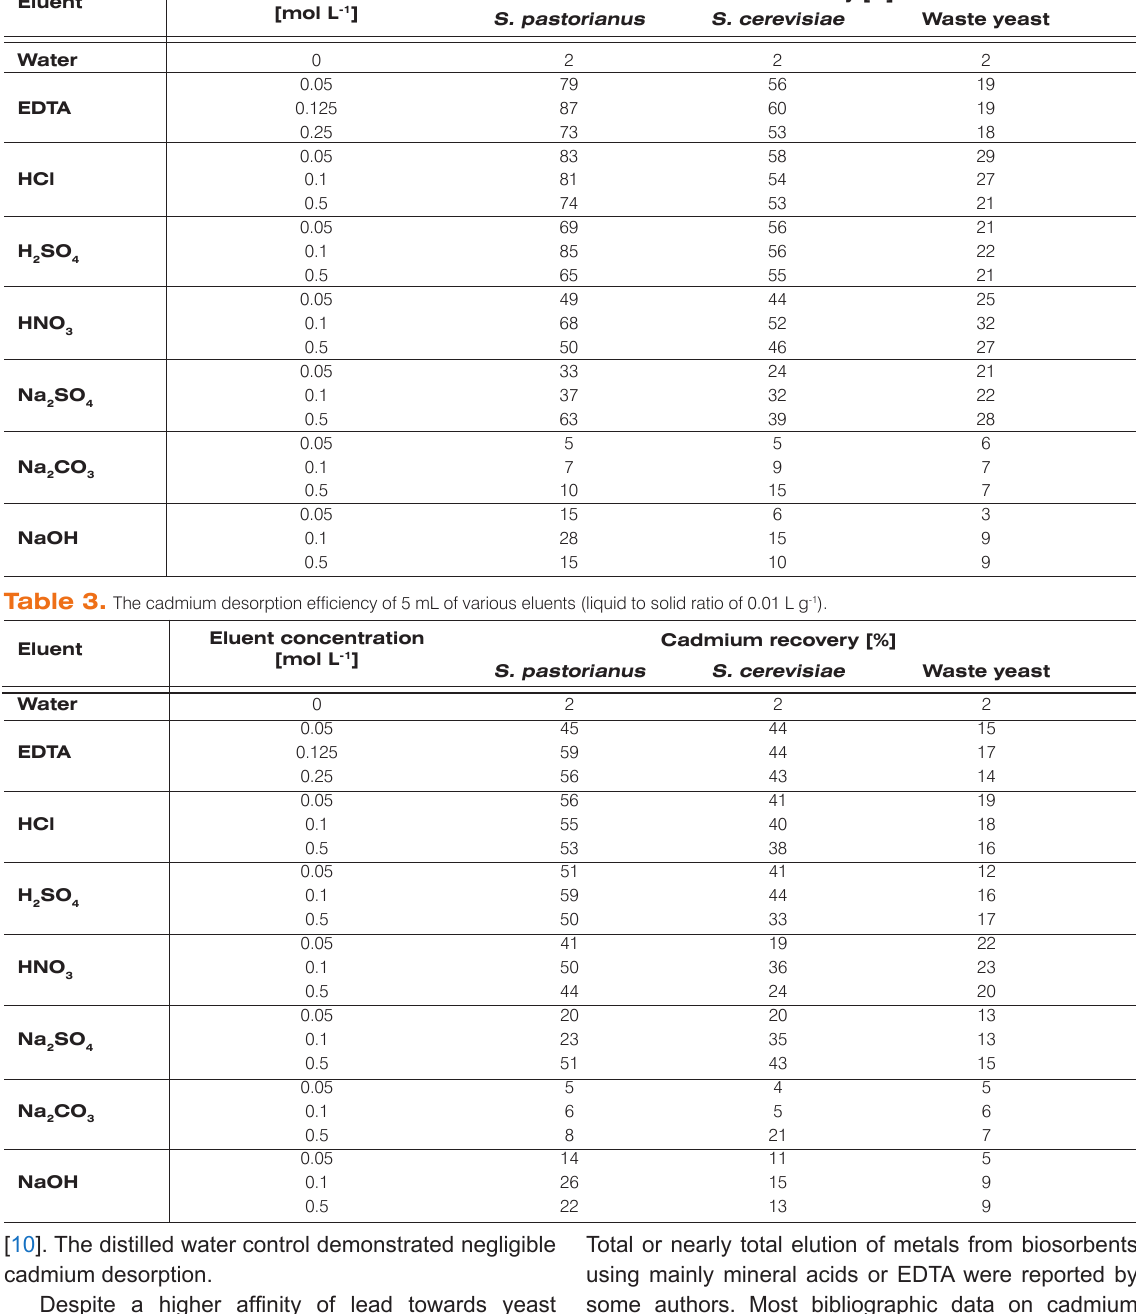
Table 2. The cadmium desorption efficiency of 10 mL of various eluents (liquid to solid ratio of 0.02 L g -1 ). Eluent concentration Eluent [mol L -1 ] Water